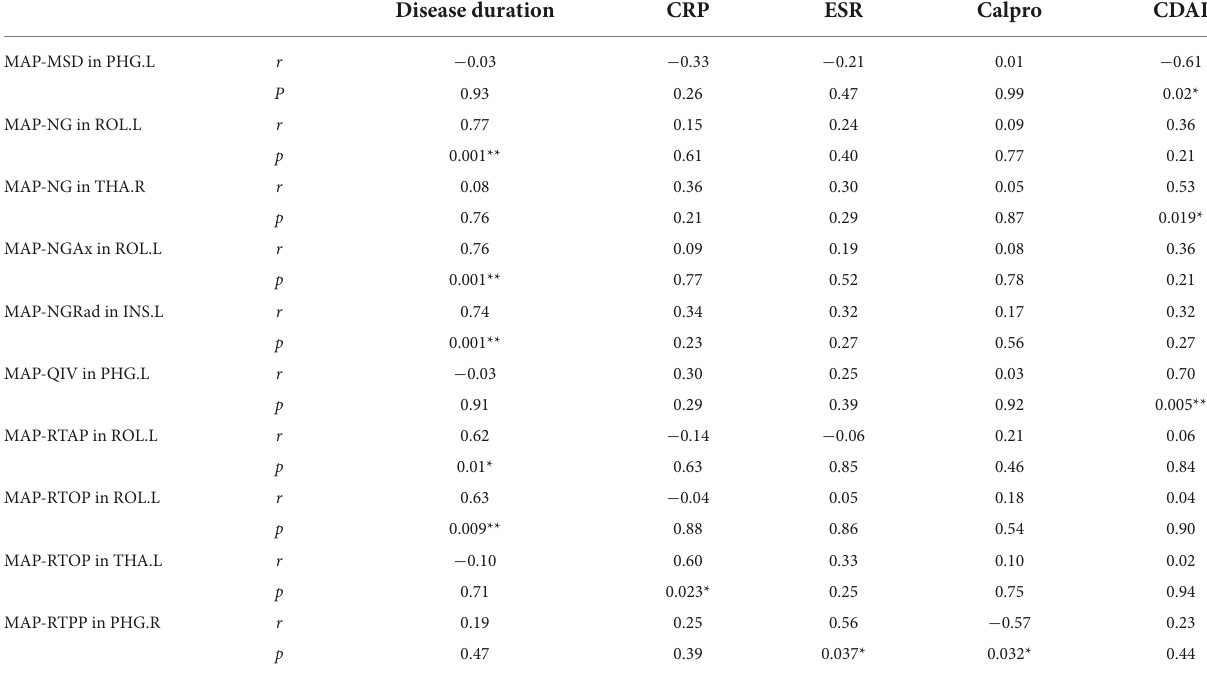
TABLE 3 Correlations between clinical characteristics and MAP parameters. Disease duration CRP ESR Calpro CDAI MAP-MSD in PHG.L r − 0.03